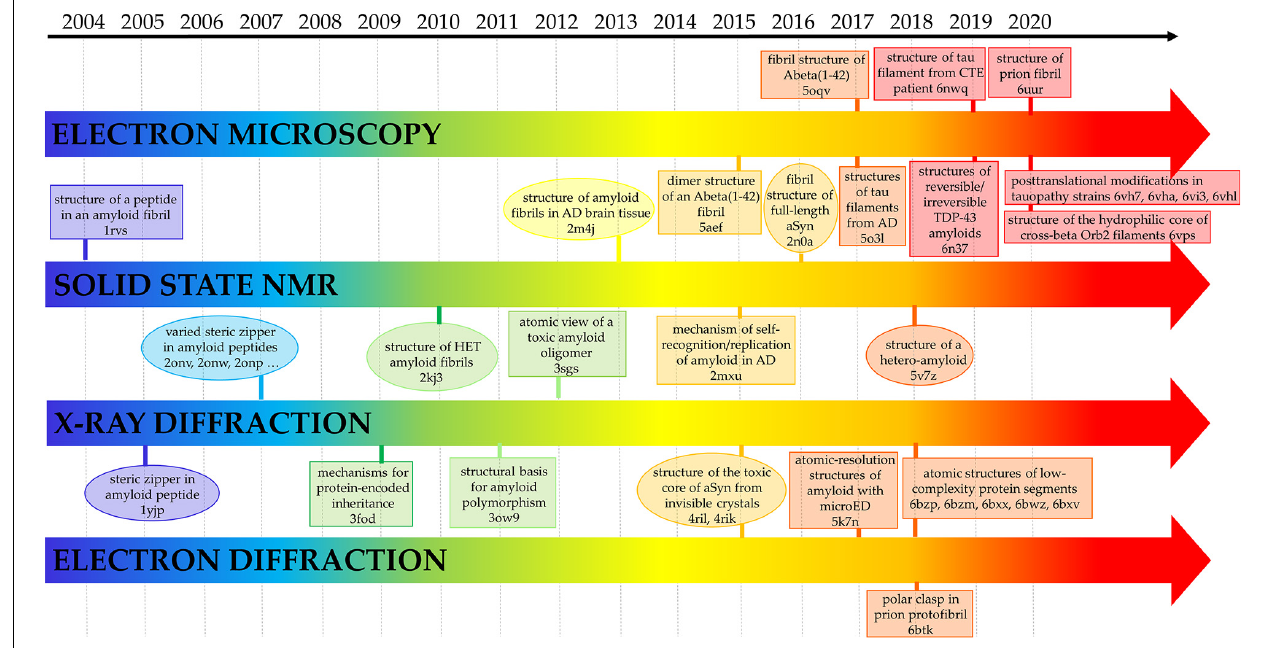
FIGURE 2 | Selected milestones in the atomic-level characterization of cross- β structures related to diseases. The Protein Data Bank code of the related structures is also reported. AD, aSyn, CTE, microED are the abbreviations for Alzheimer Disease, α -Synuclein, Chronic Traumatic Encephalopathy and micro Electro Diffraction,